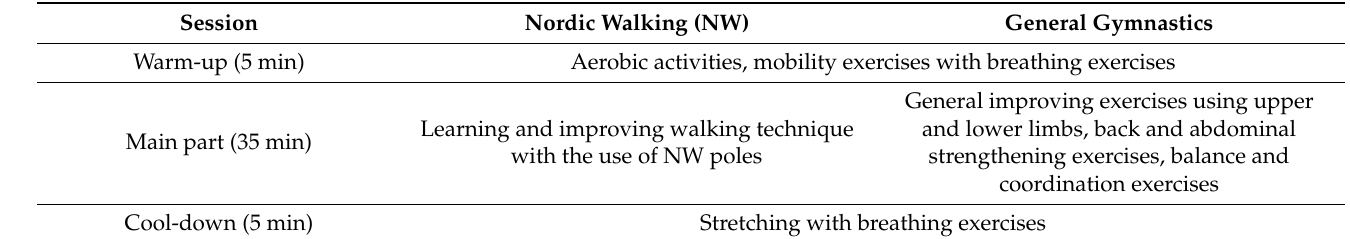
Table 1. Description of exercise programs.